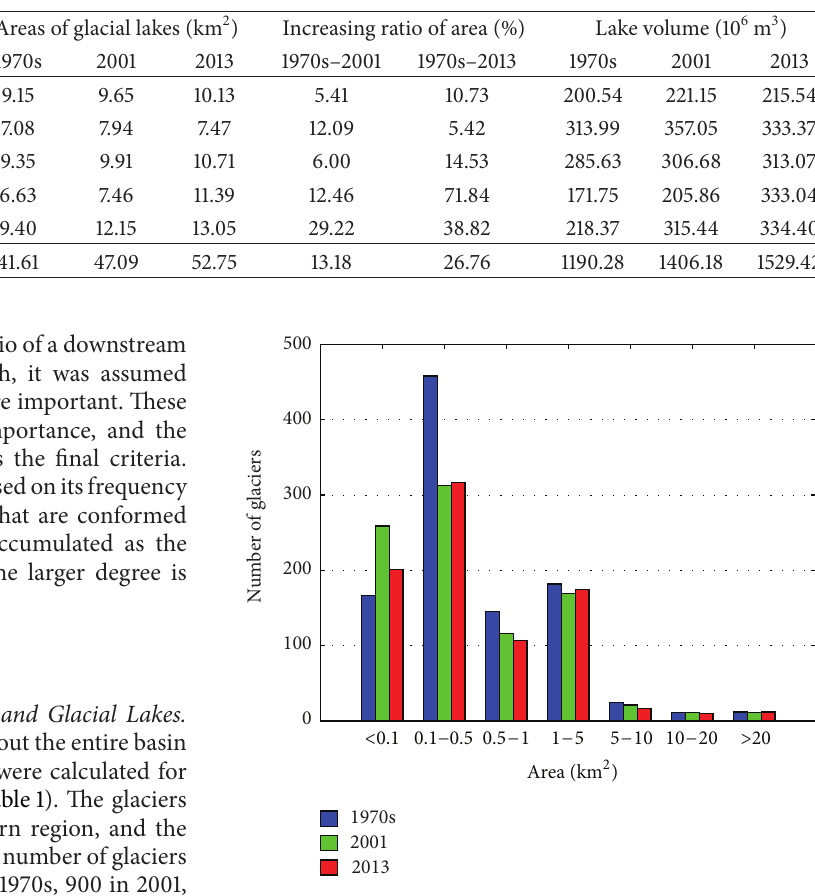
Figure 2: Changes in number and areas of glaciers for the 1970s, 2001, and 2013